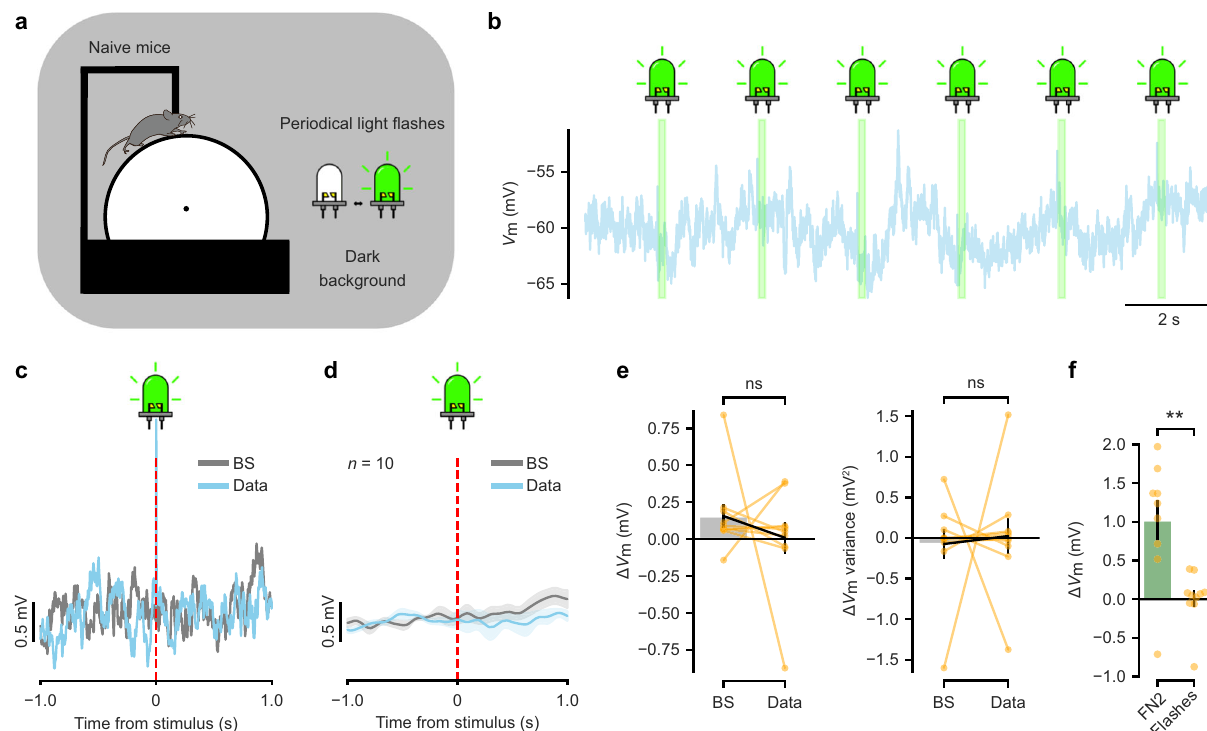
Fig. 3 Isolated visual stimuli fail to depolarise granule cells. a Schematic of the experiment. Naive head- fi xed mice move freely on a linear treadmill in a dark environment. Collimated LED light is fl ashed periodically on the eyes of the animals. b Example whole-cell recording from a granule cell during a light- fl ash experiment. The trace shows membrane potential ( V fl ash events are indicated in green. c Stimulus-aligned average from a representative m ) and light recording. The blue trace represents the mean V m aligned to light fl ash events. The grey trace represents the mean V m from a bootstrap (BS) dataset. Light fl ash event time is indicated by the vertical red dashed line (also note the presence of the stimulation artefact). d Stimulus-aligned average across multiple recordings. The blue trace represents the mean ± s.e.m. ( n = 10 cells) of low-pass fi ltered V m aligned to light fl ash events. The grey trace represents the mean ± s.e.m. of low-pass fi ltered V m from a bootstrap dataset. Light fl ash event time is indicated by the vertical red dashed line. e Left: Δ V m summary for the bootstrap dataset events (BS) and light fl ash events (Data) (0.16 ± 0.08 and 0.01 ± 0.11 mV, respectively; n = 10 cells, two-sided Wilcoxon